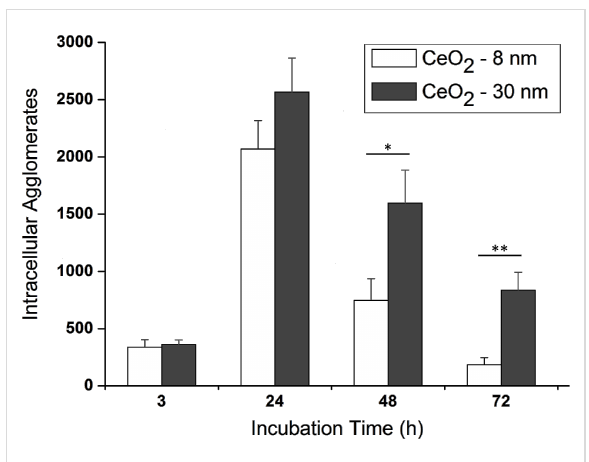
Figure 5: Uptake kinetics of 8 nm (white) and 30 nm (dark gray) ceria nanoparticles in HMEC-1 cells. The number of internalized nanoparti- cles after 3 h is practically the same for both particle sizes. These numbers then escalates to reach a maximum at around 24 h. After 48 and 72 h, however, the number of particles incorporated by the cells is reduced back to amounts similar to that measured after 3 h. The histograms show the mean ± standard error of the mean of at least two independent experiments ( n = 12–16). Results were statistically different (* p < 0.05) for an incubation time of 48 h and highly statisti- cally different (** p < 0.01) for 72